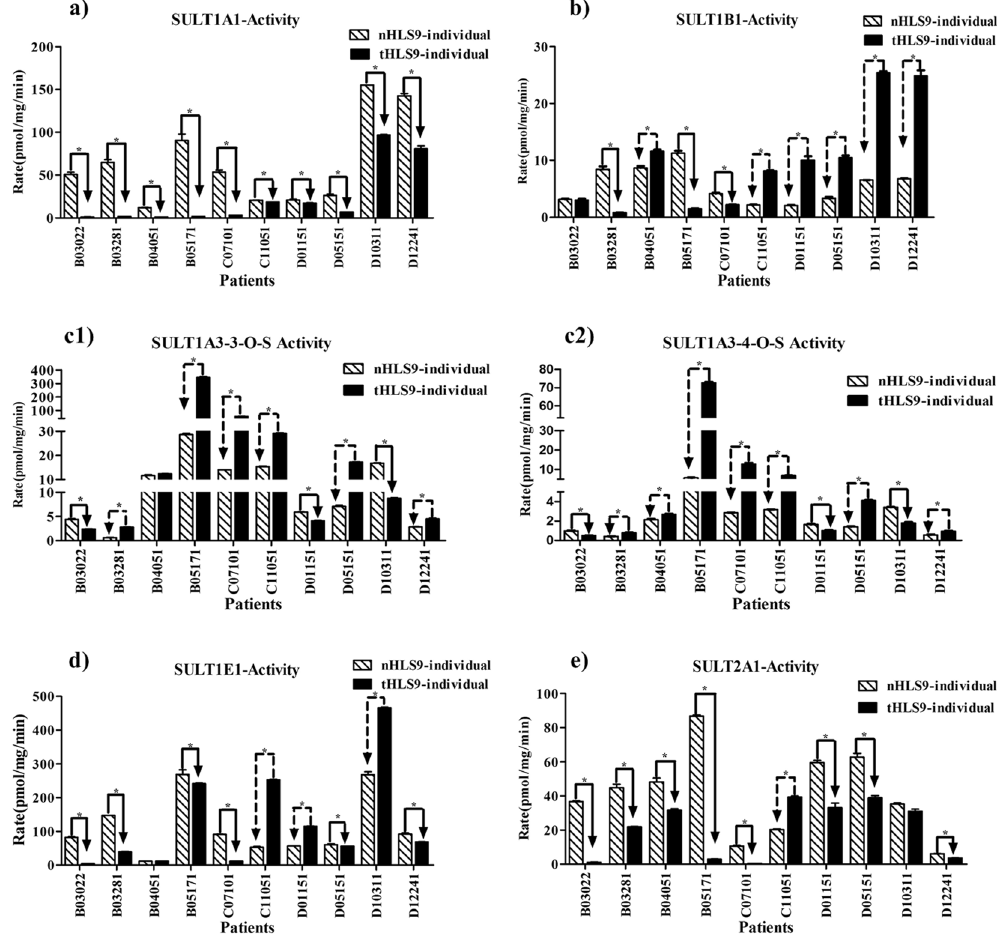
Figure 4. Activities of five SULT enzymes in human liver S9 prepared from HCC tumors (tHLS9-individual) and matched pericarcinomatous tissues (nHLS9-individual: ( a – e ). ( c1 ) dopamine 3-O-sulfate, ( c2 ) dopamine 4-O-sulfate. All the experiments were performed in triplicate, and the data are presented as mean ± SD. Paired sample t- test was performed for data analysis, and P < 0.05 was regarded as statistically